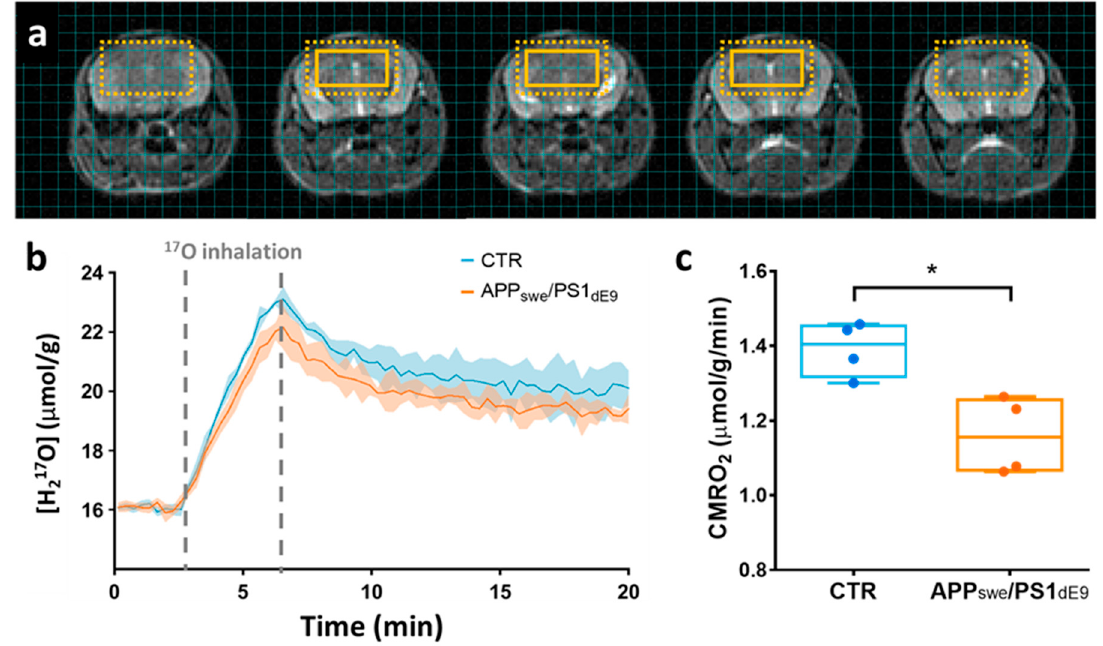
Figure 2. ( a ) Series of 5 contiguous 0.5-mm-thick anatomical images with an overlay showing the extent of the region of interest composed of 8 adjacent voxels. The dotted box indicates the effective resolution after hamming filtering (100 µ L). ( b ) Time-courses of H 2 17 O concentration in APP swe /PS1 dE9 (in orange) and wild-type CTR animals (in blue), presented as group mean ± standard deviations. Grey dotted lines indicate the 17 O 2 inhalation period. ( c ) Analysis with a linear model yielded significantly lower CMRO 2 values ( p = 0.028) in APP swe /PS1 dE9 (1.16 ± 0.10 μ mol/g of tissue/min) compared to wild-type control (1.39 ± 0.07 μ mol/g of tissue/min). * p < 0.05 (Mann-Whitney’s U test).